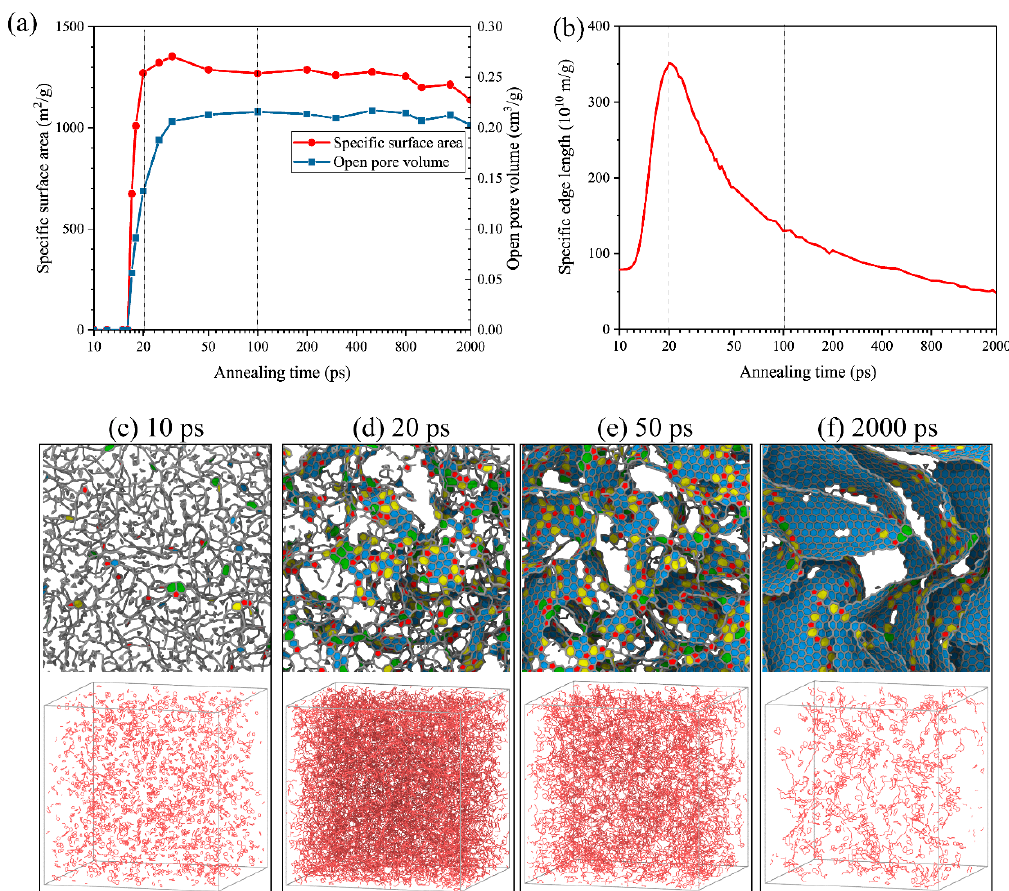
Figure 1. ( a ) Evolution of specific surface area and open pore volume during the annealing process. ( b ) The specific edge length of fragments as a function of annealing time. ( c – f ) Snapshots of local pores (upper) and the configuration of edges (below) at several annealing points. Rings are distinguished by different colors (pentagon in red, hexagon in blue, heptagon in yellow, octagon in green).